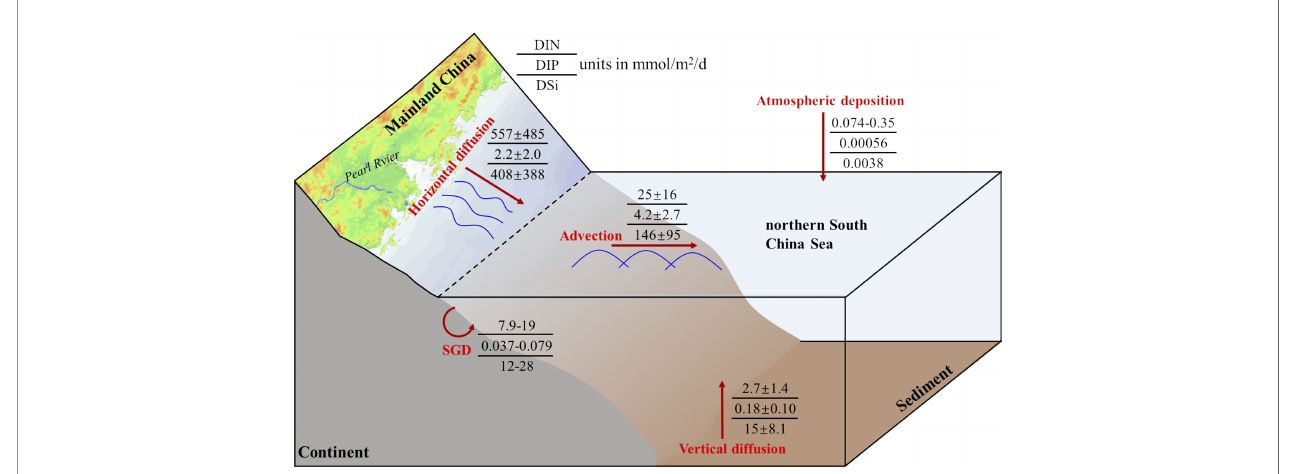
FIGURE 10 | Schematic diagram of nutrient sources and mixing in the NSCS of our interest during June